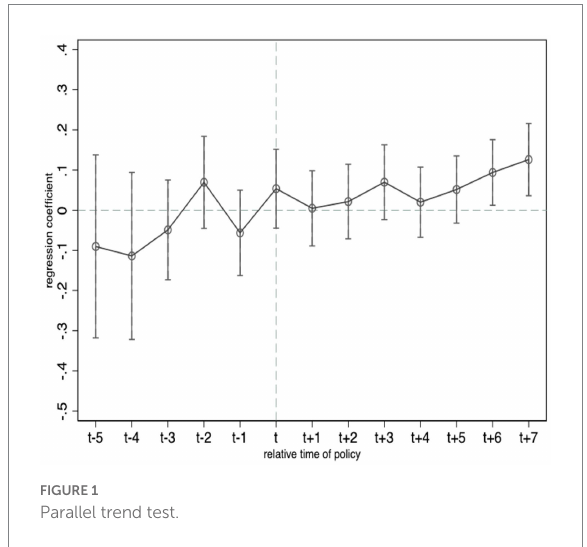
FIGURE 1 Parallel trend